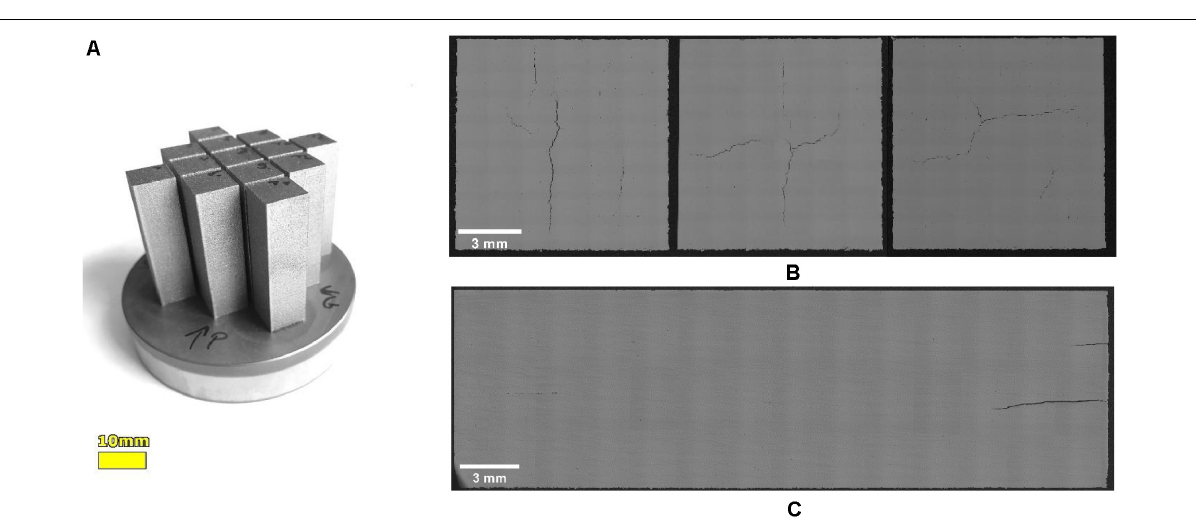
Figure 2A . From the values that correspond to the 10th (D10) and 90th (D90) percentile, it was estimated that the particle size was ranging between 17 and 48 µ m. The presence of fine particles (diameter < 15 µ m) did not affect the flowability of the powder during processing. The cumulative distribution graph obtained by optical measurement confirmed that the majority of the particles were highly circular (circularity ≥ 0.9) as seen in Figure 2B .